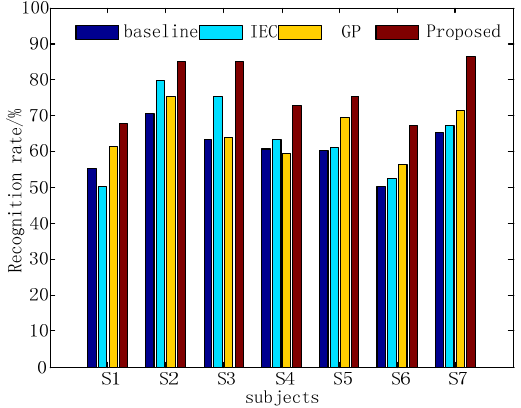
Figure 8. Comparisons of the recognition rate for speech.